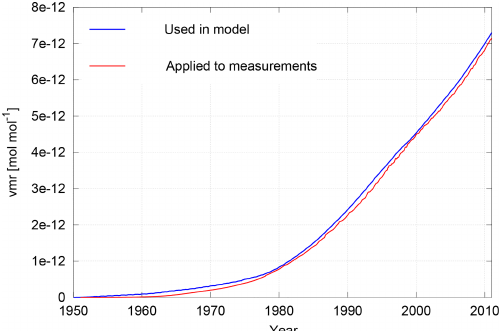
Figure 3. Globally averaged SF 6 time series on the ground as used in the RC1-base-07 simulation (blue) and as used with the observa- tion calculations